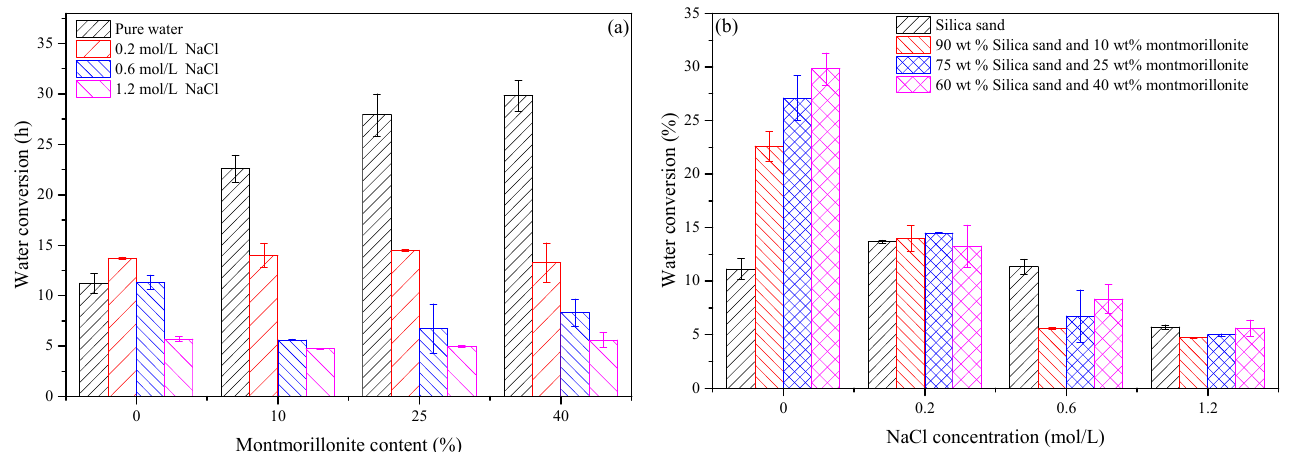
Figure 8. Summary of water conversion. ( a ) Water conversion under different NaCl concentrations. ( b ) Water conversion under different montmorillonite contents.